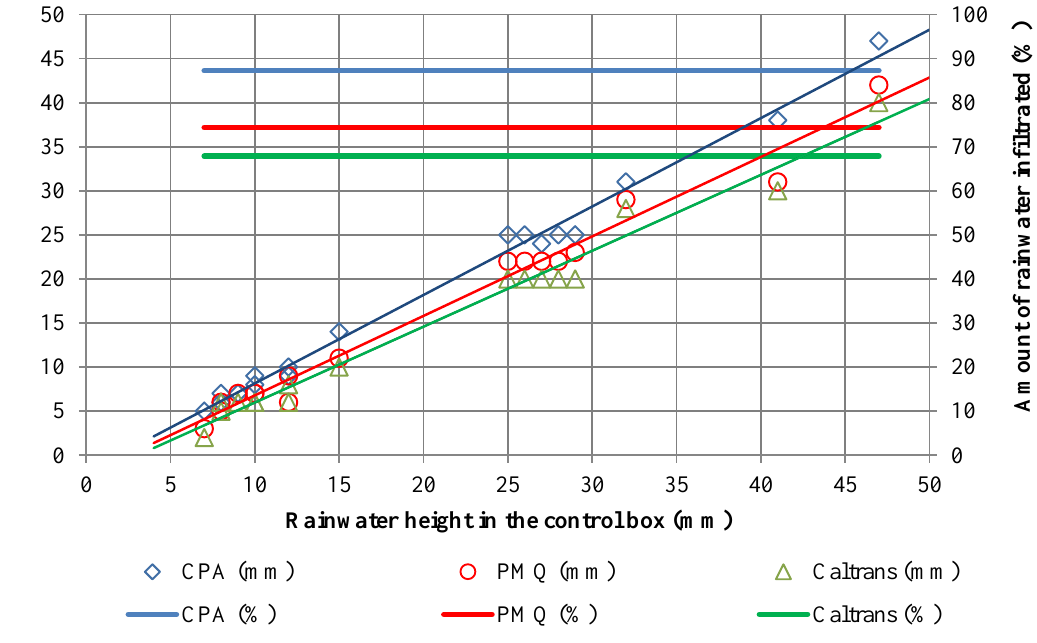
Figure 5. Amount of rainwater infiltrated through the porous asphalt mixtures slabs.